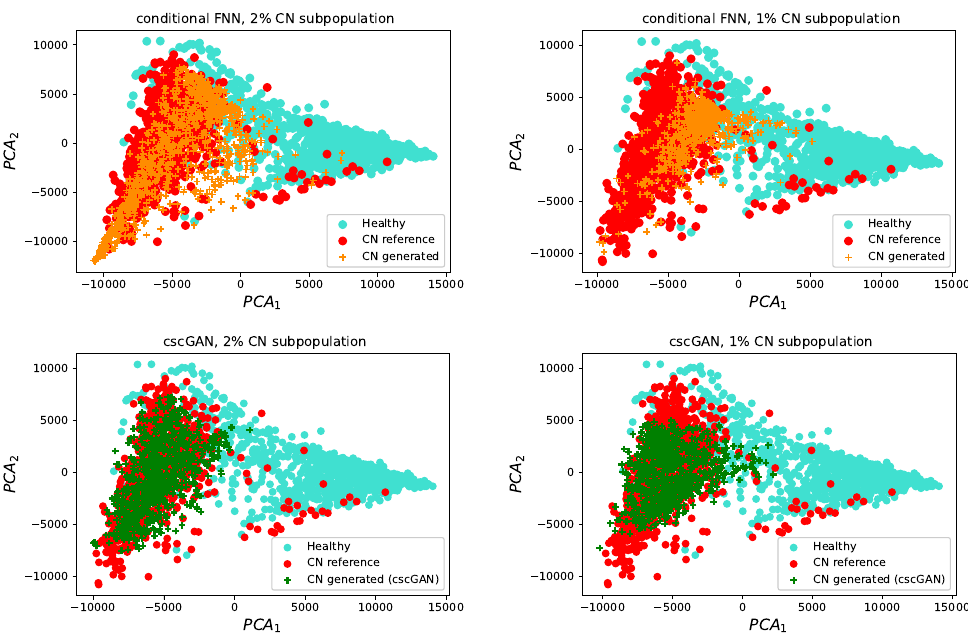
Figure 6. Two dimensional PCA plots on the real 16-dimensional count data. Healthy (turquoise) and diseased (red) cell distributions, each consisting of N = 26,000 samples, are shown in each subplot as reference. Cross symbols indicate the generated cell distributions. ( top ) Performance of cFNN when the training set comprises of 2% (left) and 1% (right) diseased samples. ( bottom ) cscGAN generated data for the same training data sets. Both models are equally capable of data augmentation of underrepresented